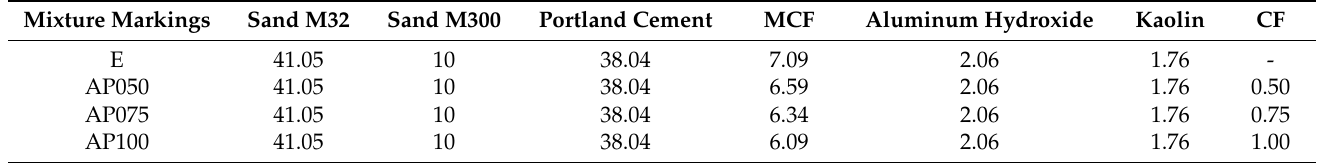
Table 2. The amount of raw materials in the different mixtures in %.